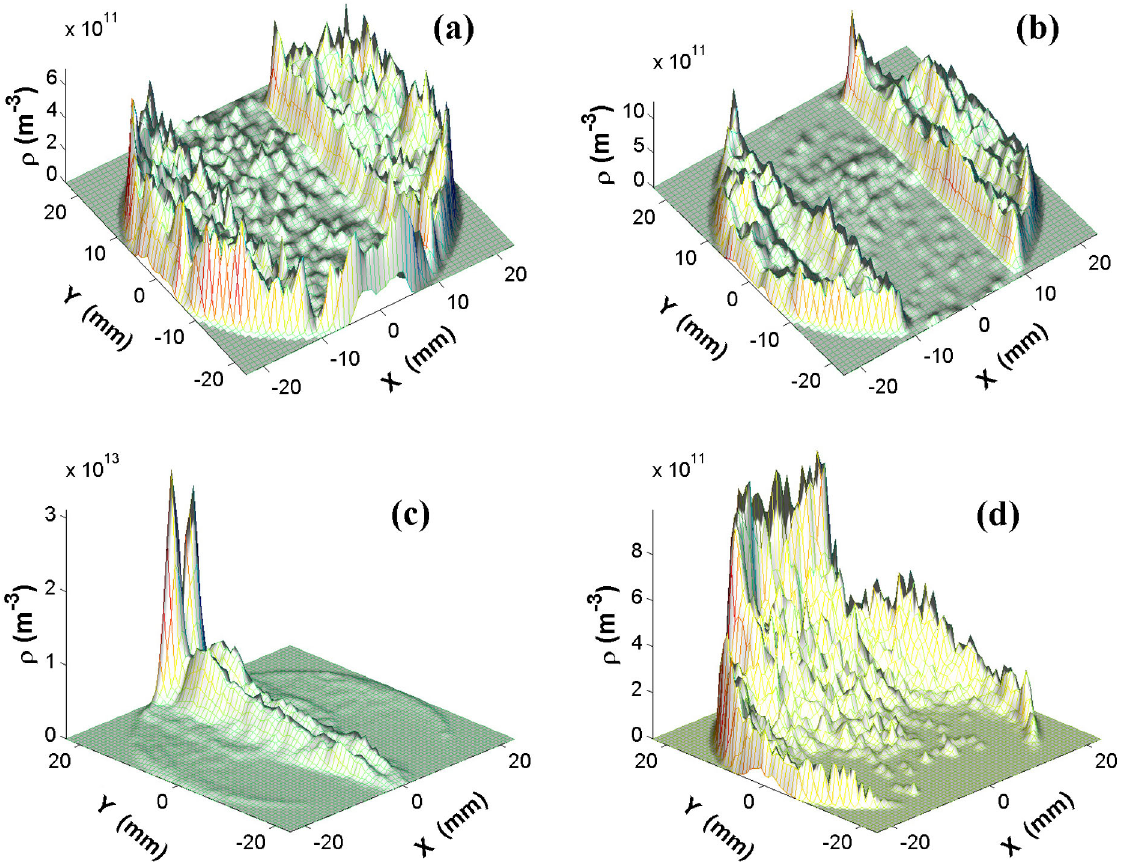
FIG. 19. Simulated EC transverse distributions at a wiggler magnet pole center for four values of the clearing voltage: (a) þ 100 V; (b) þ 600 V; (c) − 300 V; (d) − 600